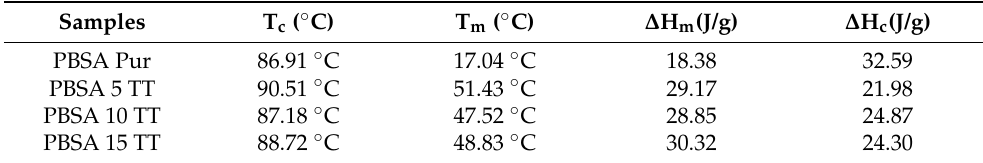
Table 4. Thermal properties of pure PBSA and its composites.